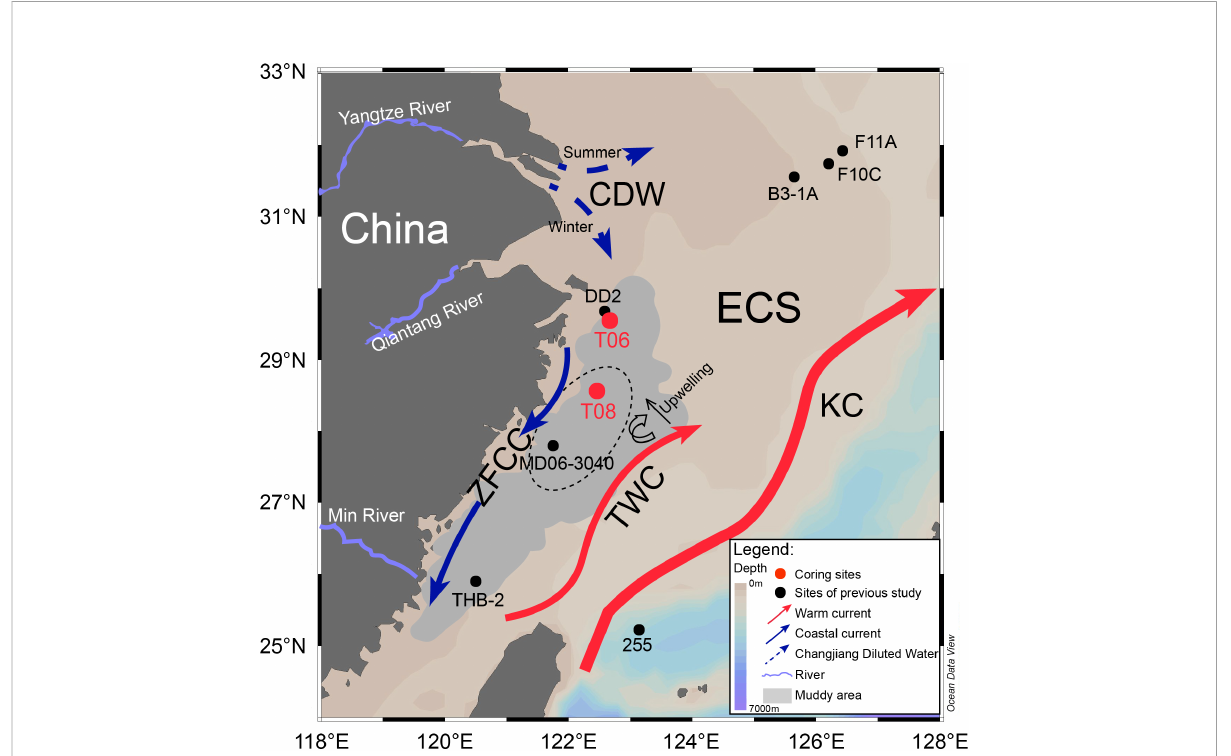
FIGURE 1 A map showing the locations of cores T06 and T08 and the circulation system in the ECS. The area marked by the gray shadow represents the depocenter of the ECS inner shelf and we use the following abbreviations: Kuroshio Current — KC; Taiwan Warm Current — TWC; Zhejiang Fujian Coastal Current — ZFCC; Changjiang Diluted Water — CDW. 255, THB-2, MD06-3040, DD2, B3-1A, F10C, and F11A denote the cores from which we compile data for comparison with our records. The black dashed circle represents main upwelling cell (Liu et al., 2007). (A detailed list of abbreviations and references to previous studies can be found in Supplementary